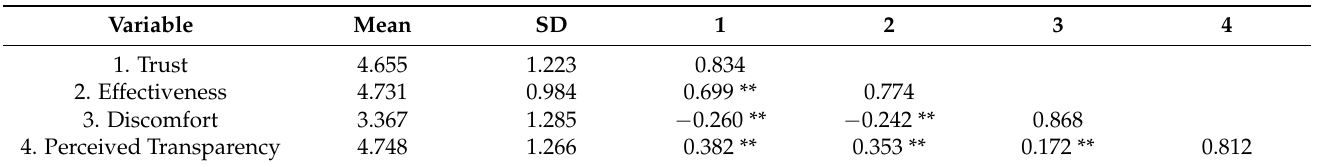
Table 3. The mean value, standard deviation, correlation coefficient matrix, and square root of the average of all